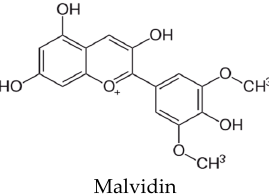
Figure 4. Examples of plant-based molecules able to inhibit QS-regulated processes.